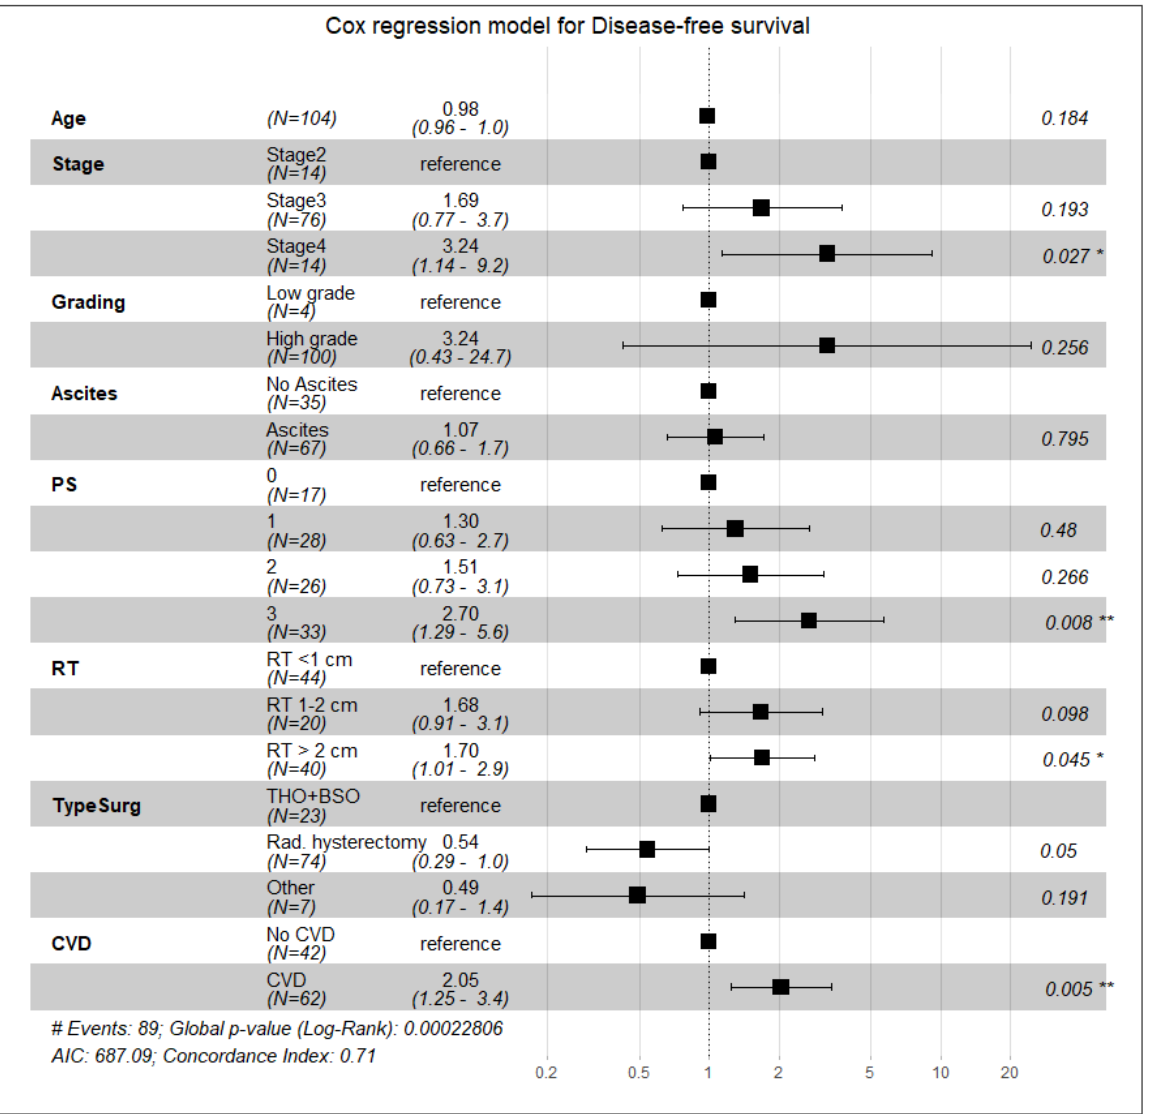
Figure 4. Forest plot. Cox regression multivariate analysis of the impact of various variables and cardiovascular diseases on disease-free survival. Statistical power 0.27. (* p ≤ 0.05, ** p ≤ 0.01; # Events = number of events)